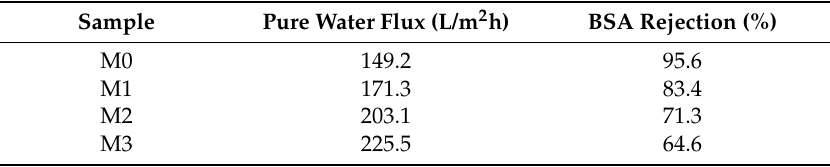
Table 4. Pure water fluxes and BSA rejections of the prepared